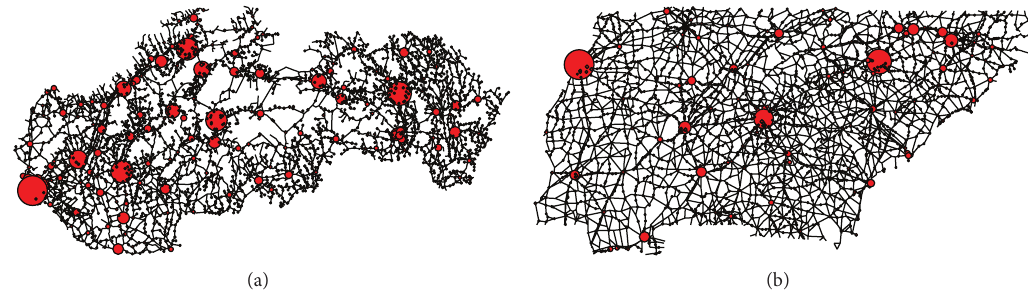
Figure 2: Road networks used to test the algorithm A-LEX. All inhabited nodes (marked red) are considered as aggregate customers and possible locations of facilities. The diameter of nodes is scaled proportionally to the population. (a) The road network of the Slovak Republic consists of |𝐽| = 2928 aggregate customers representing the locations of |𝐽| = 5384 909 individuals. (b) The joined road network of six